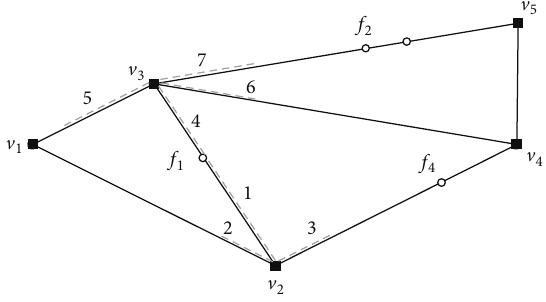
Figure 7: Generating segments of a